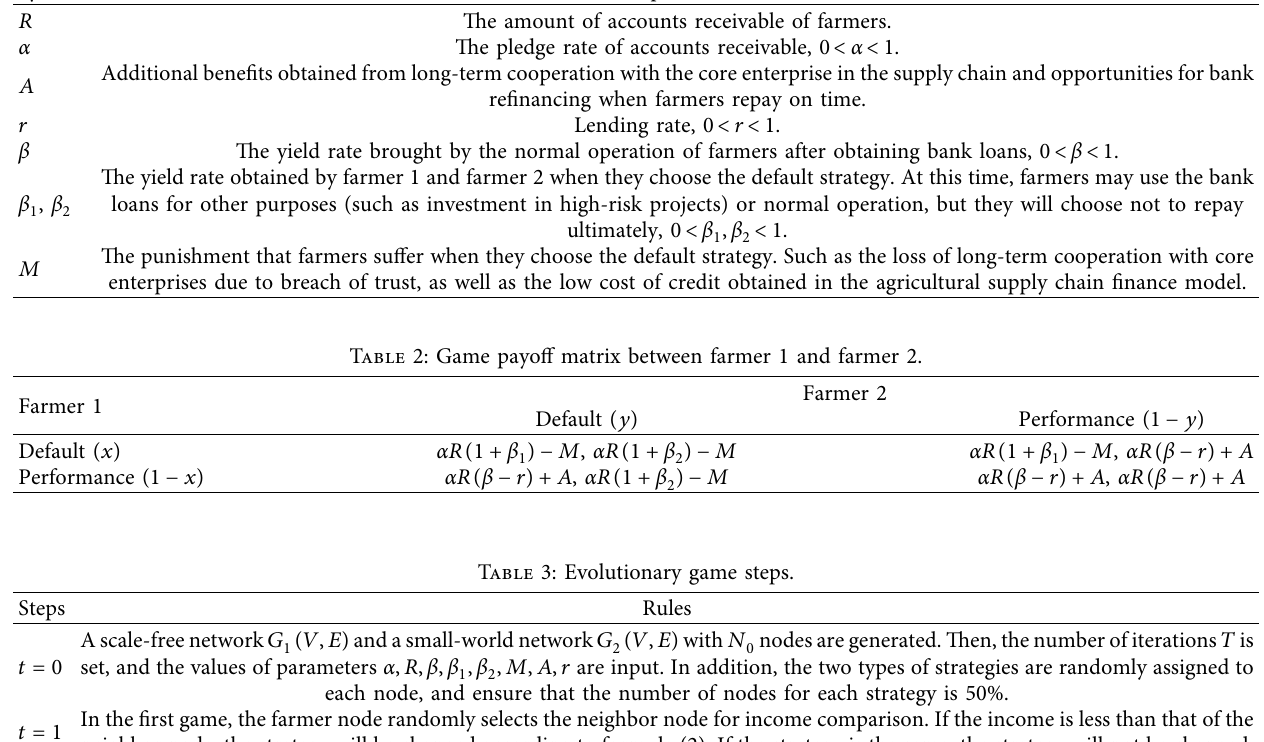
Figure 2, the default diffusion curve in the scale-free network shows a trend of constant fluctuation.